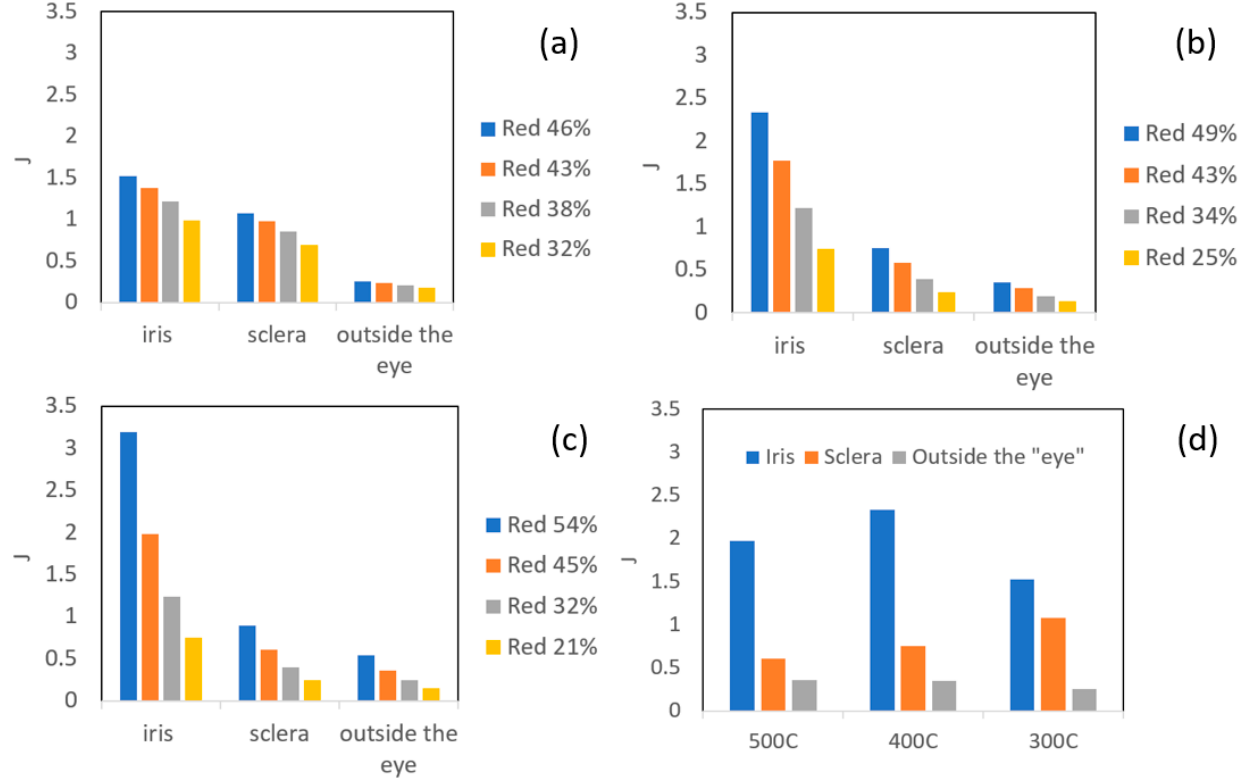
Figure 9. Comparison between bonding quality parameter J at the following temperatures: 300 °C ( a ), 400 °C ( b ), 500 °C ( c ) at different reduction values. J at different temperatures with similar reduction of about 45% ( d ).